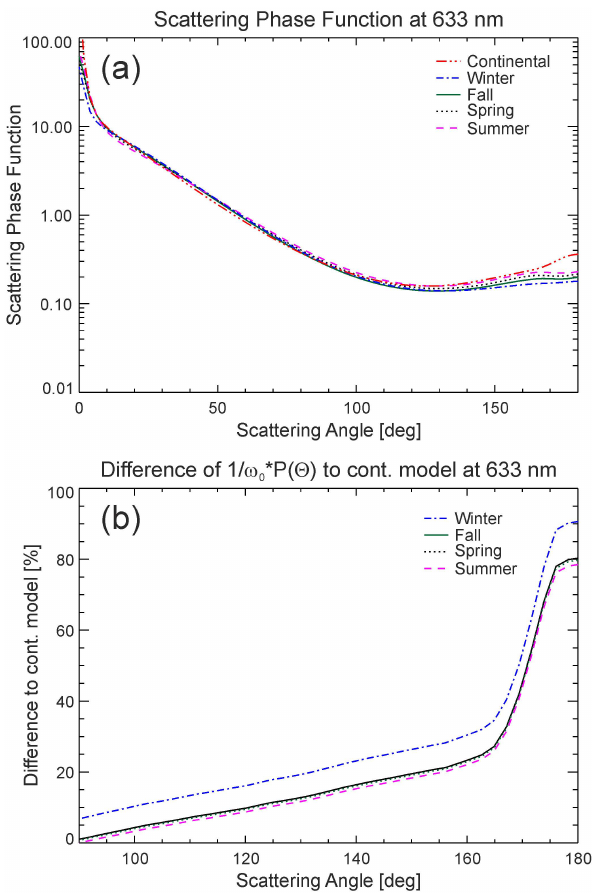
Fig. 2. (a) Scattering phase functions at 633nm for the conti- nental aerosol model of 6S and the seasonal models derived from AERONET inversion products for the new method. (b) Difference of 1 /ω 0 P(2) between the seasonal aerosol models and the conti- nental aerosol